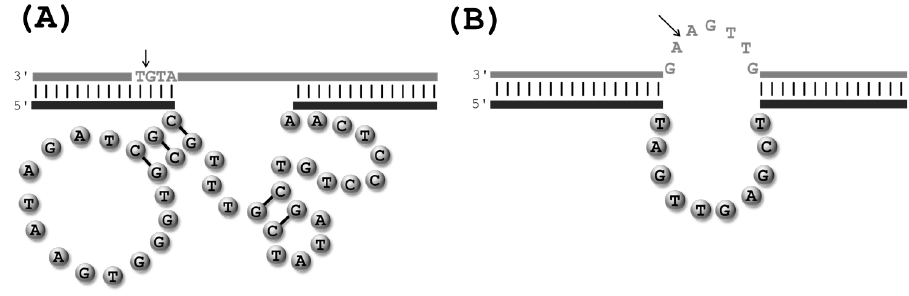
Figure 5. Sequences and hypothetical 2D structures of the DNA-cleaving DNAzymes 10MD5 [48] ( A ) and I-R3 [49] ( B ). and I-R3 [49] ( B